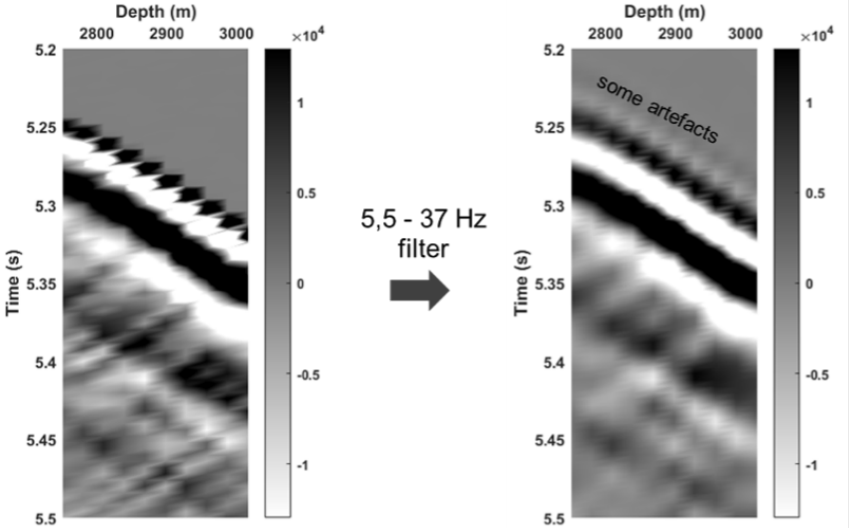
Figure 8. Check shot data before and after the band-pass filter. Although reducing aliasing, it introduces minor artifact above the first